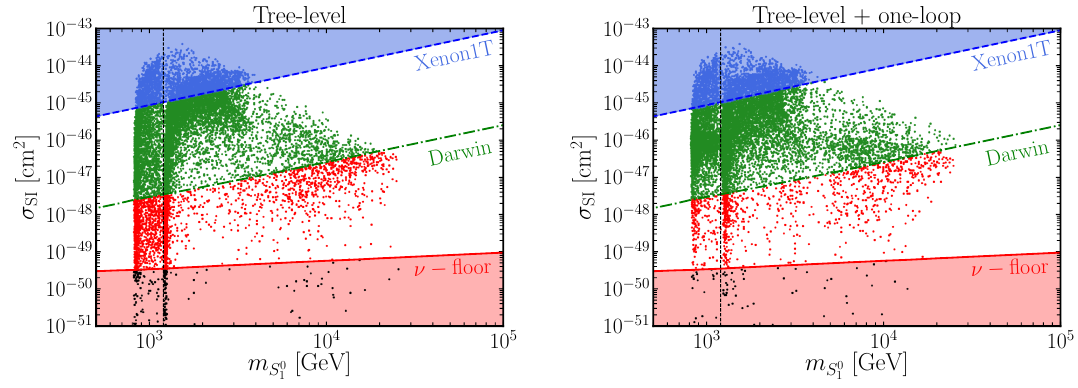
Figure 5 . Dark matter spin independent direct detection cross section as a function of the lightest neutral scalar mass. Constraints from the Xenon1T experiment [38] are shown in blue in addition to the future sensitivity achievement of the upcoming Darwin experiment [61] in green and the so-called neutrino floor [62] in red. Blue dots are excluded by Xenon1T. Green dots will be probed by Darwin. Red (black) dots correspond to points above (below) the neutrino